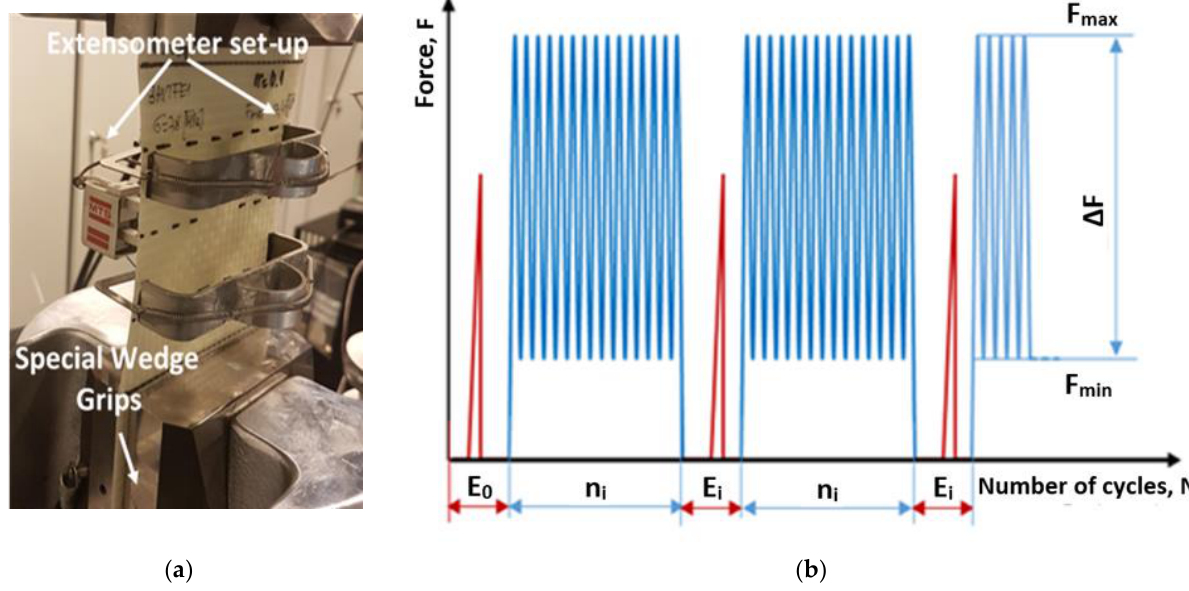
Figure 2. ( a ) Experimental setup for fatigue aging tests; ( b ) schematic illustration of the loading sequences. Cyclic loading was carried out under force control and frequency of 2 Hz. The sinusoidal loading mode was characterized by R = F min /F max =